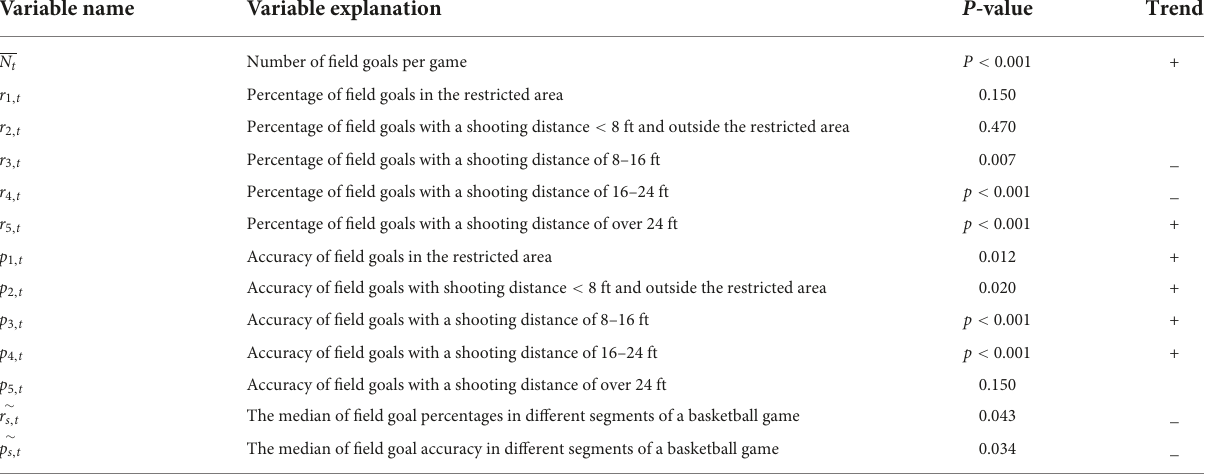
TABLE 1 The P -values of the Mann-Kendall trend test for different variables in this